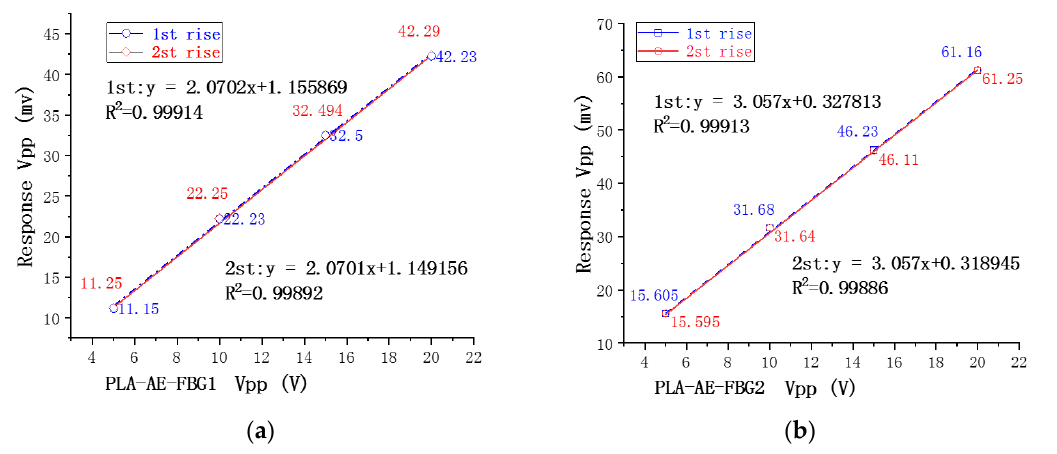
Figure 18. Fitting the data curve under different amplitude excitations ( a ) When the peak-peak value of the excitation signal is raised from 5 V to 20 V, the fitting data curve of PLA-AE-FBG1; ( b ) When the peak-peak value of the excitation signal is raised from 5 V to 20 V, the fitting data curve of